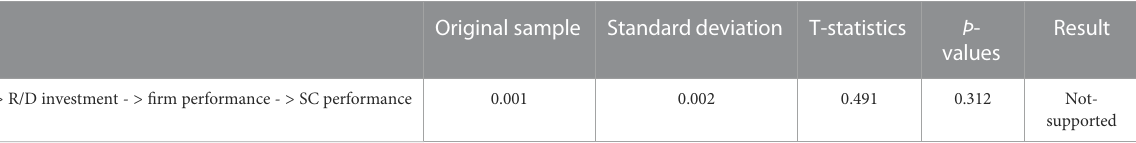
TABLE 5 Speci fi c indirect effects with the t-value and beta coef fi